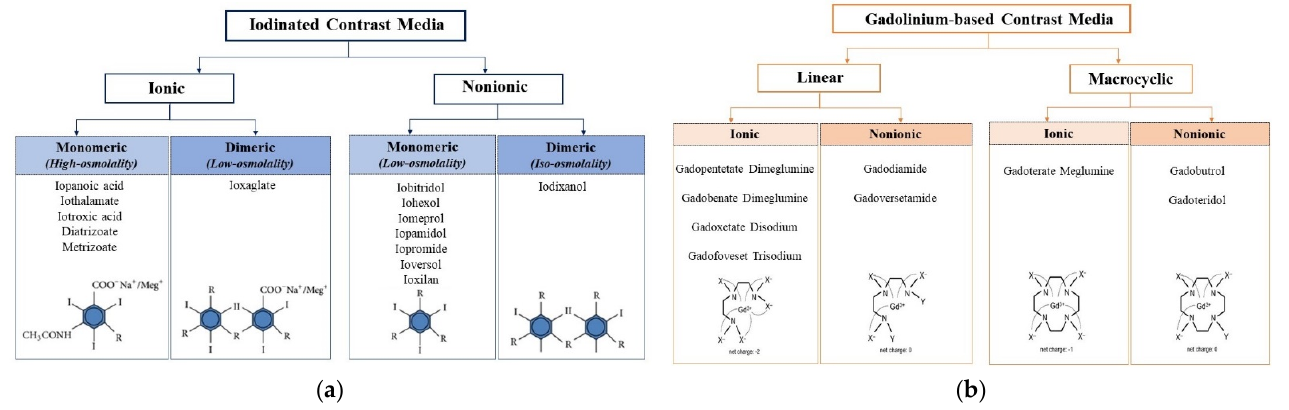
Figure 1. Classification of iodinated contrast media ( a ) and gadolinium-based contrast media ( b ) based on structural and chemical properties.